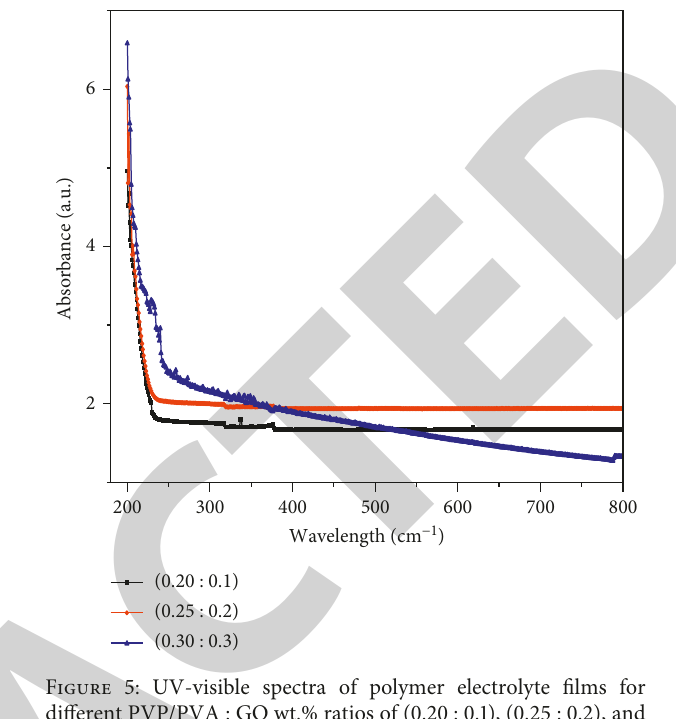
Figure 5: UV-visible spectra of polymer electrolyte films for different PVP/PVA : GO wt.% ratios of (0.20 : 0.1), (0.25 : 0.2), and (0.30 :